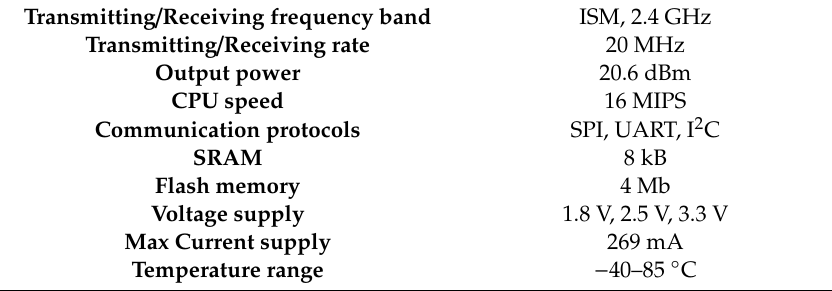
Table 3. Specifications of the Microchip ATWINC1500-MR210PA chip installed in the Wi-Fi module.